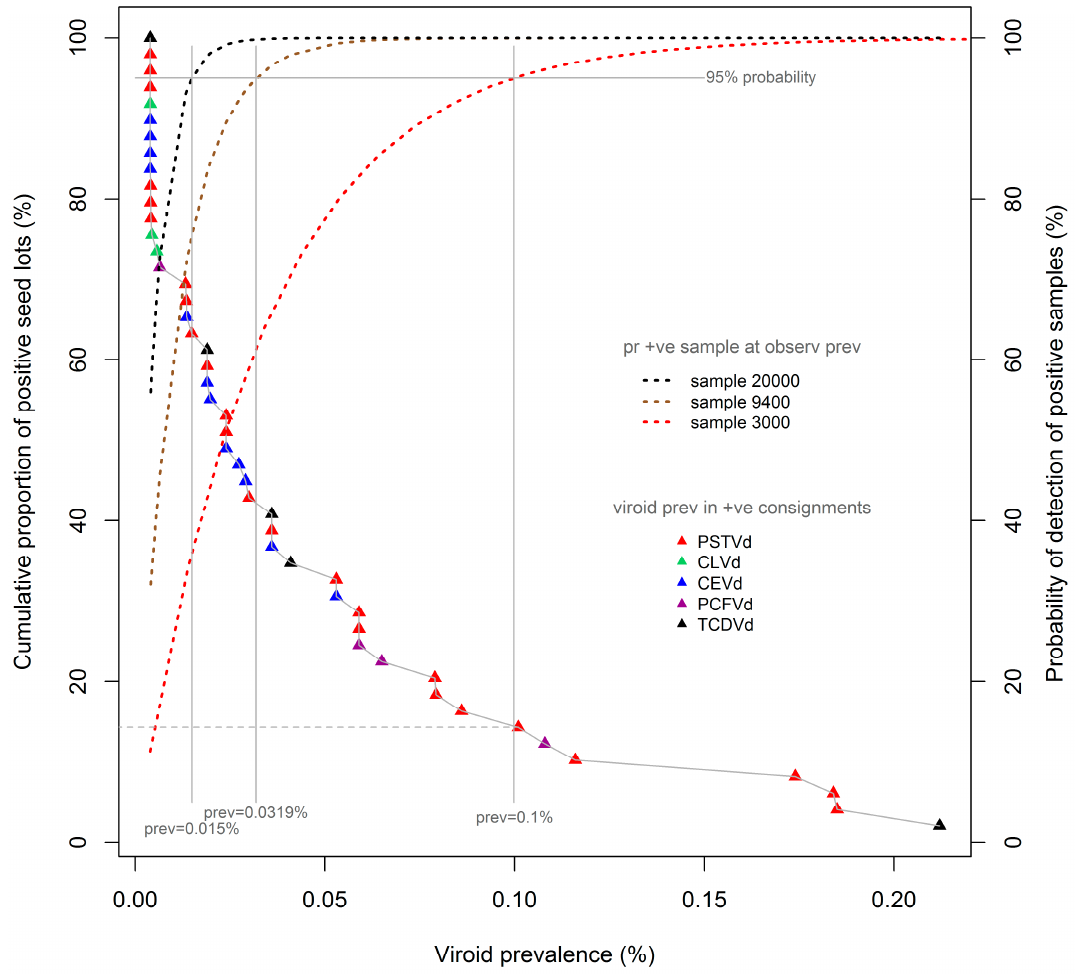
Figure 2. Cumulative distribution curve of viroid prevalence for contaminated tomato seed lots, overlaid with statistical confidence level (CL) curves (dotted lines) for three test sample sizes. See Figure 1 and text for interpretation.